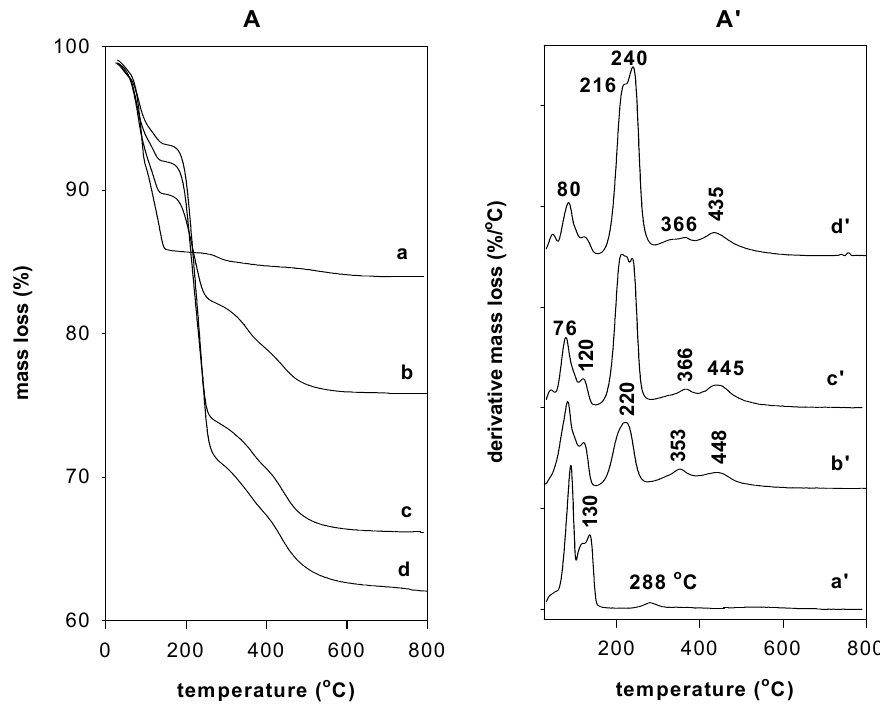
Figure 7. TGA ( A ) and DTG ( A’ ) features of ( a , a’ ) Na-magadiite treated with different concentrations: ( b , b’ ) 0.40 mM, ( c , c’ ) 0.80 mM, and ( d , d’ ) 1.20 mM of C16TMABr solution.